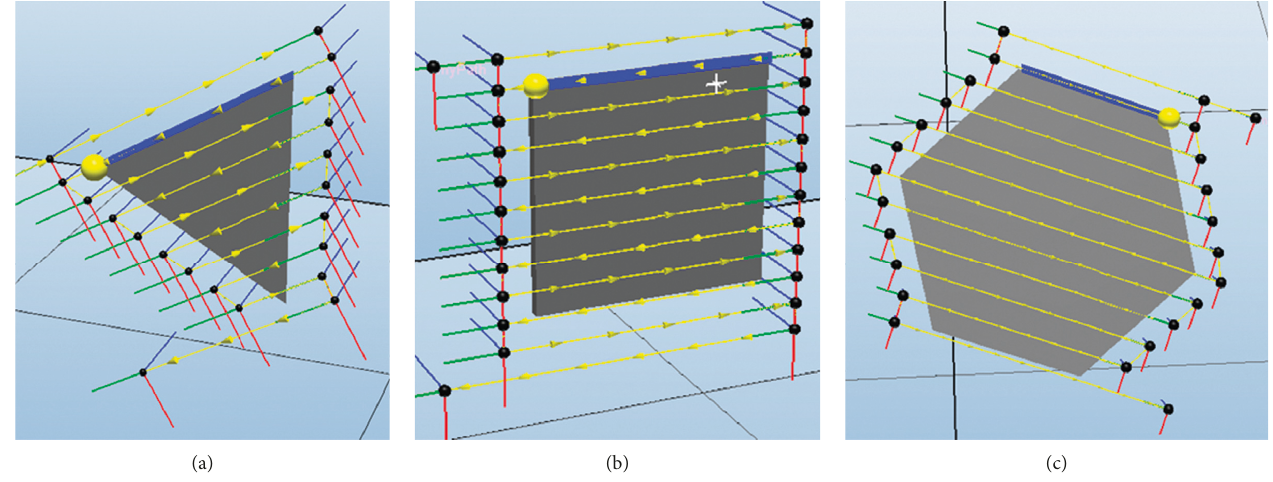
Figure 11: Autogenerated trajectory on a type of regular straight-edge polygons.